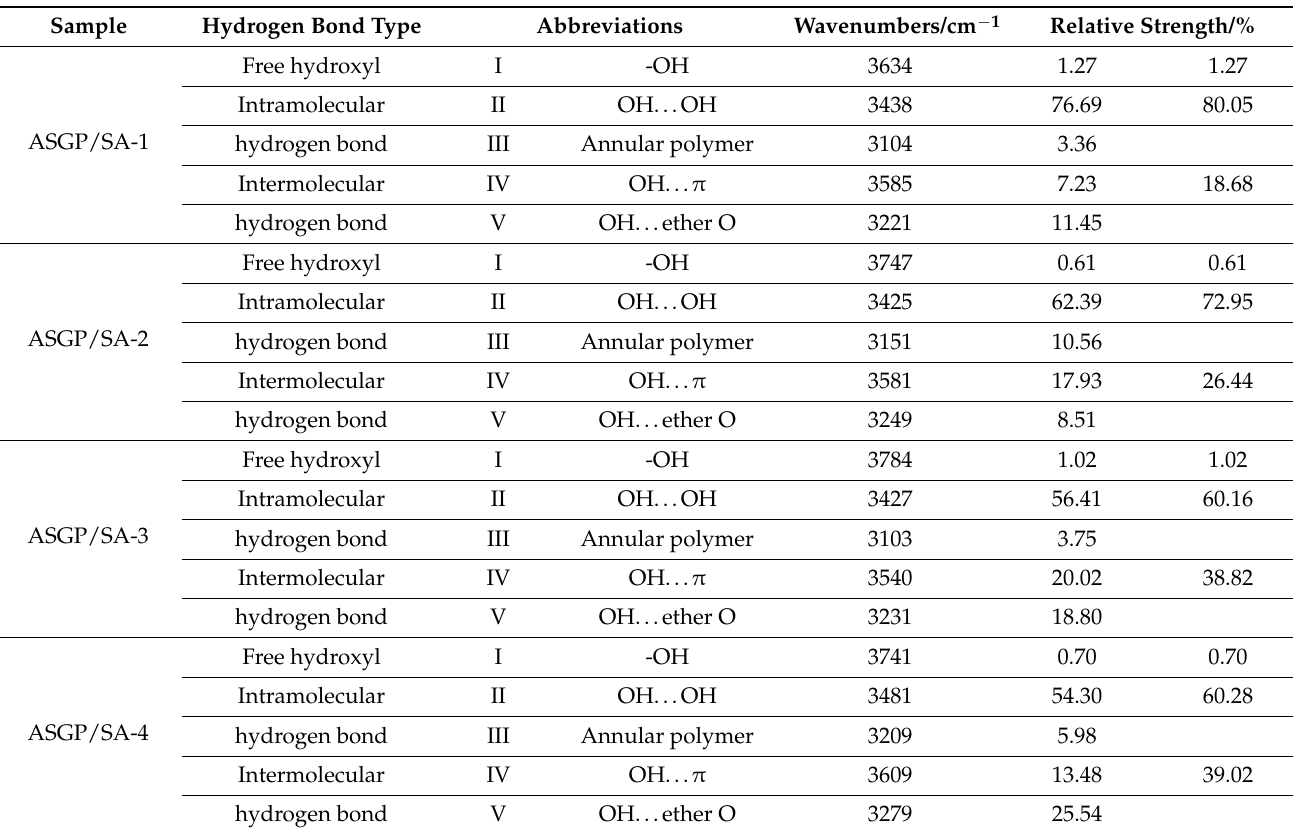
Table 3. Gauss fitting results of hydrogen bond for drug-loaded